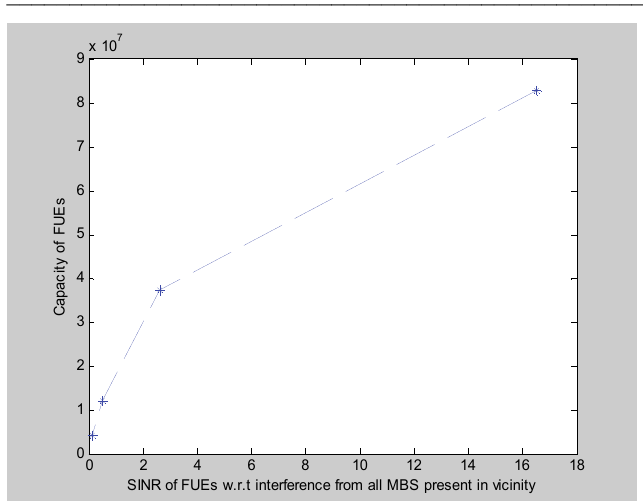
Fig. 9. SINR & Capacity of FUEs w.r.t. interference from MBSs.